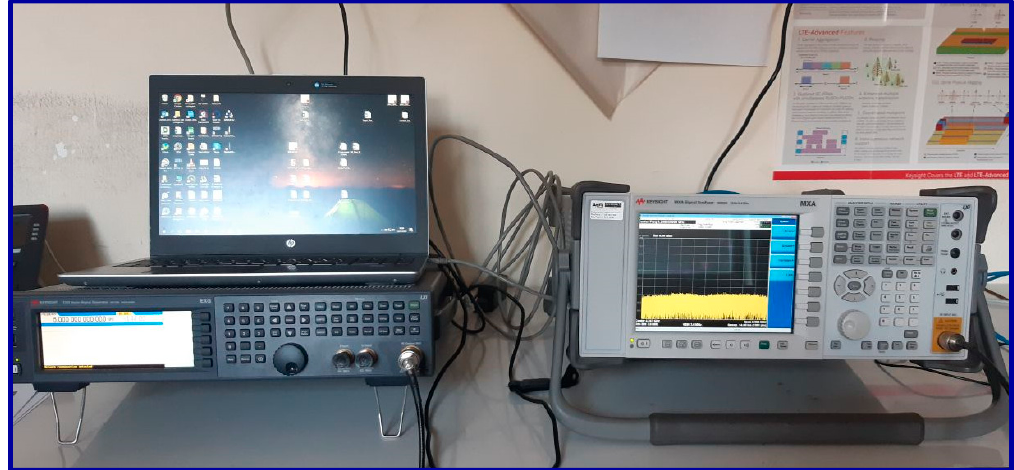
Figure 6. The experimental setup. The generated 5G signals are carried by a coaxial N-type cable from a Vector Signal Generator (on the left) to a Vector Signal Analyzer (on the right). A personal computer (PC) running a demodulation 5G software is also used.